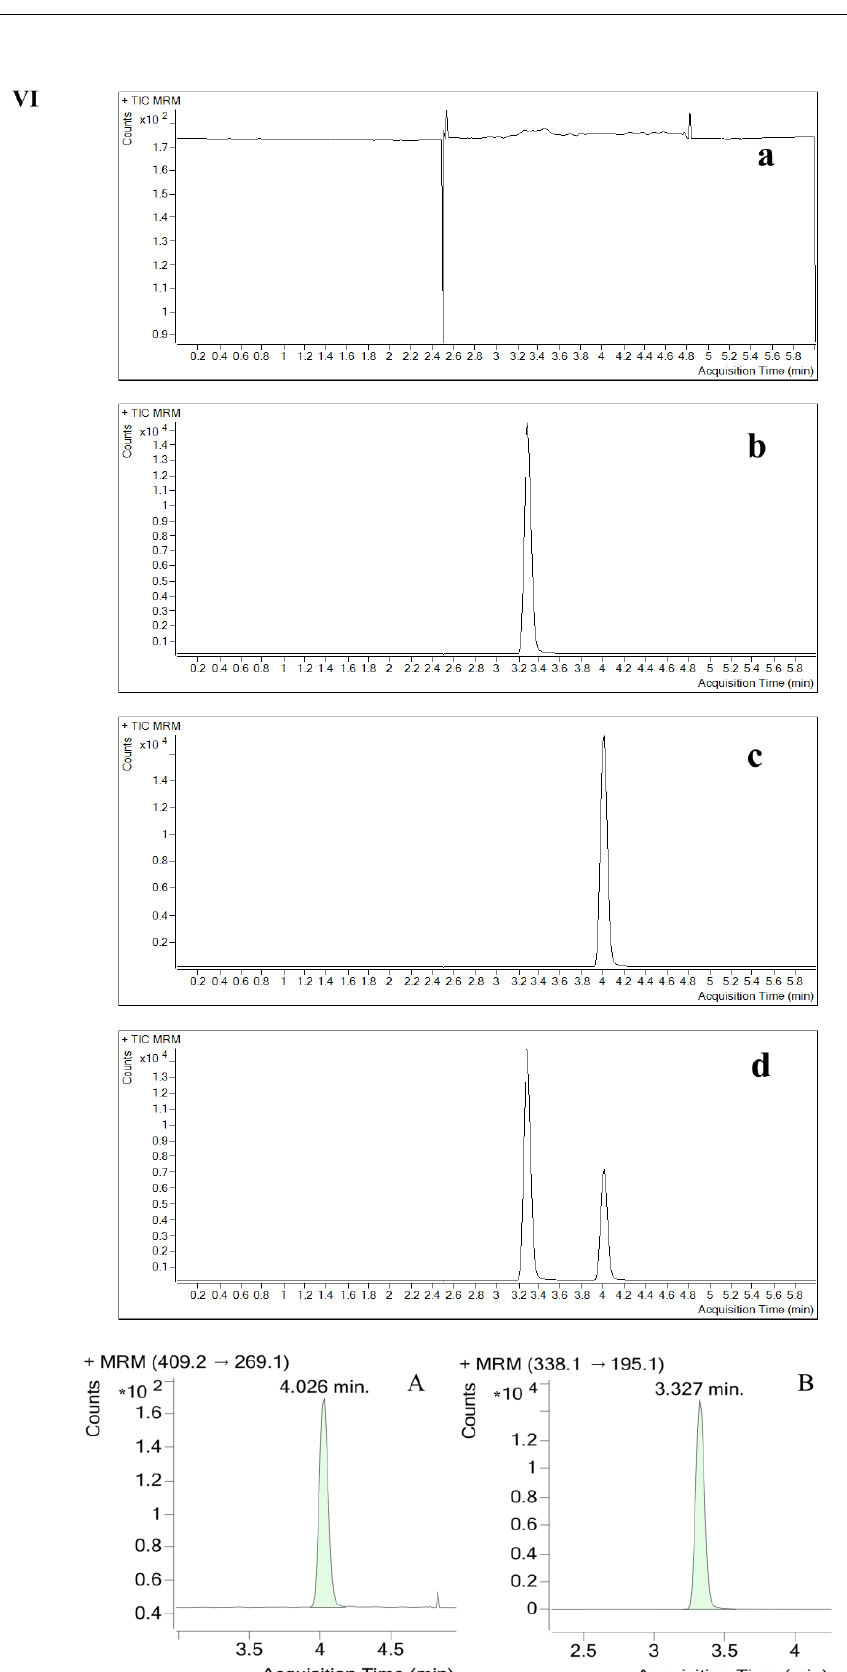
Figure 1. Specificity and selectivity of the method in plasma. ( a ) double blank, ( b ) single blank, ( c ) analyte only and ( d ) analyte and IS (in six different lots). Chromatograms of contezolid ( A ) and linezolid ( B ).